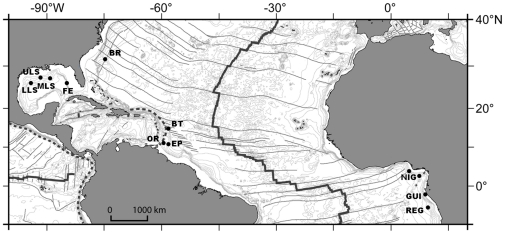
Locations of known cold-seep sites along the Atlantic Equatorial Belt.Gulf of Mexico: ULS, MLS, LLS: upper, middle and lower Louisiana slope, FE: Florida Escarpment; BR: Blake Ridge diapir; Barbados prism: OR: Orenoque A & B sectors, EP: El Pilar sector, BT: Barbados trench; Gulf of Guinea: REG: Regab pockmark, GUI: Guiness area, NIG: Nigerian slope. For depths and references refer to Table 1. The Nigerian slope sites have been only partially sampled.